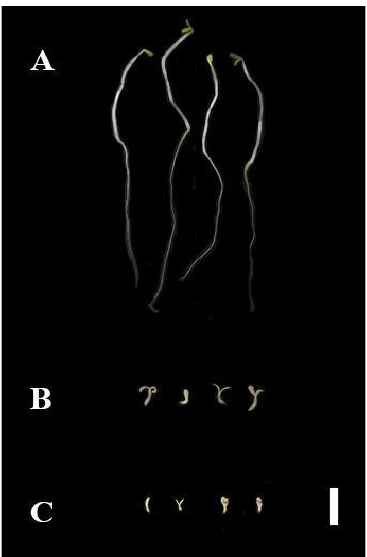
Figure 3. Pre-emergence bioassay with lettuce. Seedings at the end of 8 days of application of ( A ) distilled water, ( B ) purified saponin (QB) at 1%, and ( C ) QB 2%. Bar = 1 cm. Statistical data on whole seedling length (cm): distilled water (7.65 ± 0.93 a); QB at 1% (0.60 ± 0.14 b) and QB at 2% (0.38 ± 0.05 b). Numbers in brackets are means ± SD. Means sharing the same letter do not differ by one-way ANOVA and Tukey test ( p ≤ 0.05).